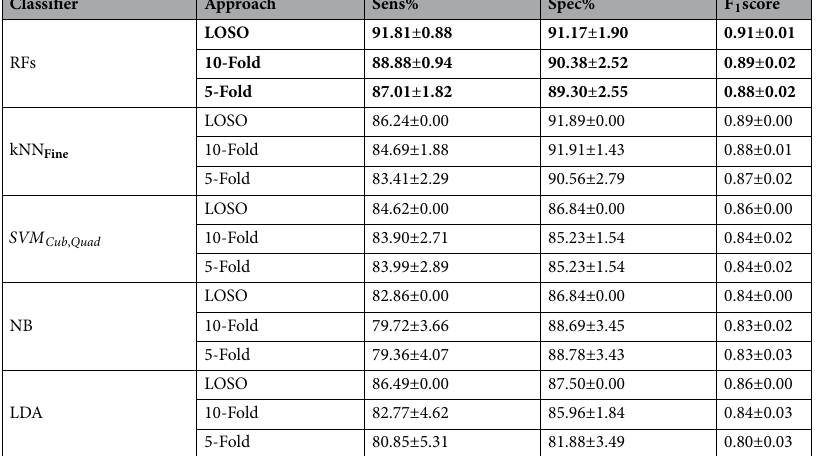
Table 5. Comparison of the first stage classification performance Using the integrated markers of the developed CAD system: Benign (LR1-2) vs. Intermediate (LR3) vs. Malignant (LR4-5) using different machine learning classifiers and three validation approaches for each classifier (i.e. LOSO, 10-Fold, and 5-Fold). Let Sens, Spec, RFs, KNN, SVM, NB, and LDA denote sensitivity, specificity, random forests, k-nearest neighbor, support vector machine, naive Bayes, and linear discriminant analysis, respectively.